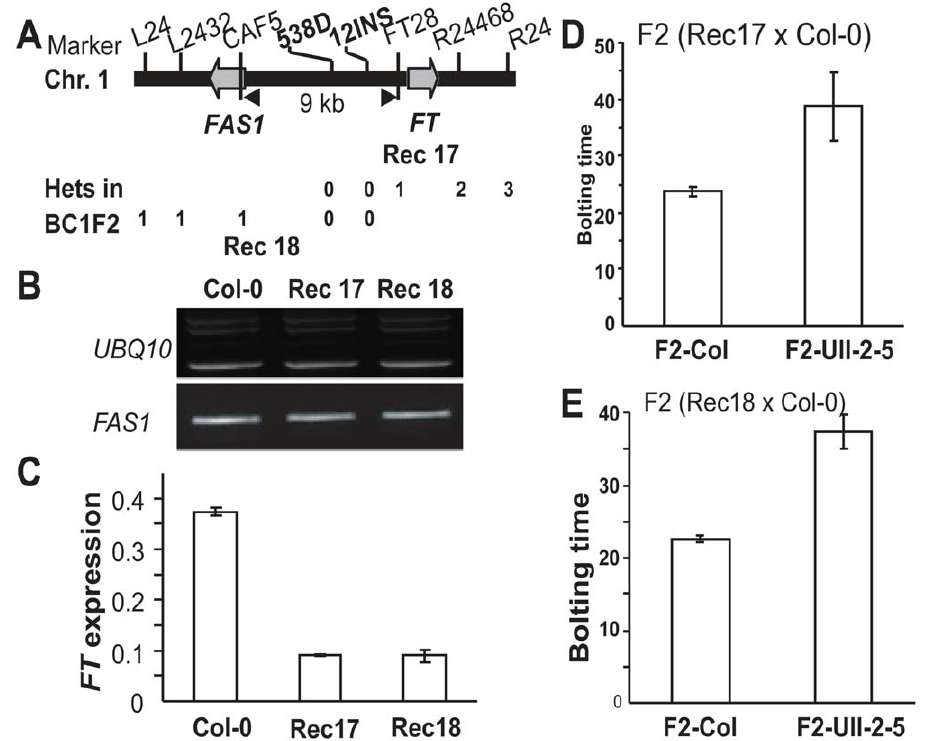
Figure 2. Fine-mapping and allelic analysis of the QTL on chromosome 1. (A) Fine-mapping of the QTL – the later flowering time variation co-segregated with marker 538D and 12INS. (B) FAS1 expression in Col-0 and two recombinants plants Rec17 and Rec18. (C) FT expression in Col-0, Rec17 and Rec18. FT expression level was normalized to UBC . (D and E) Segregation analysis of the F2 population obtained from Rec17 (D) and Rec18 (E) crossed to Col-0 respectively. Error bars in (B) and (C) show S. D. from three experimental replicates, in (D) and (E) shows S. D. of at least 20 individuals.